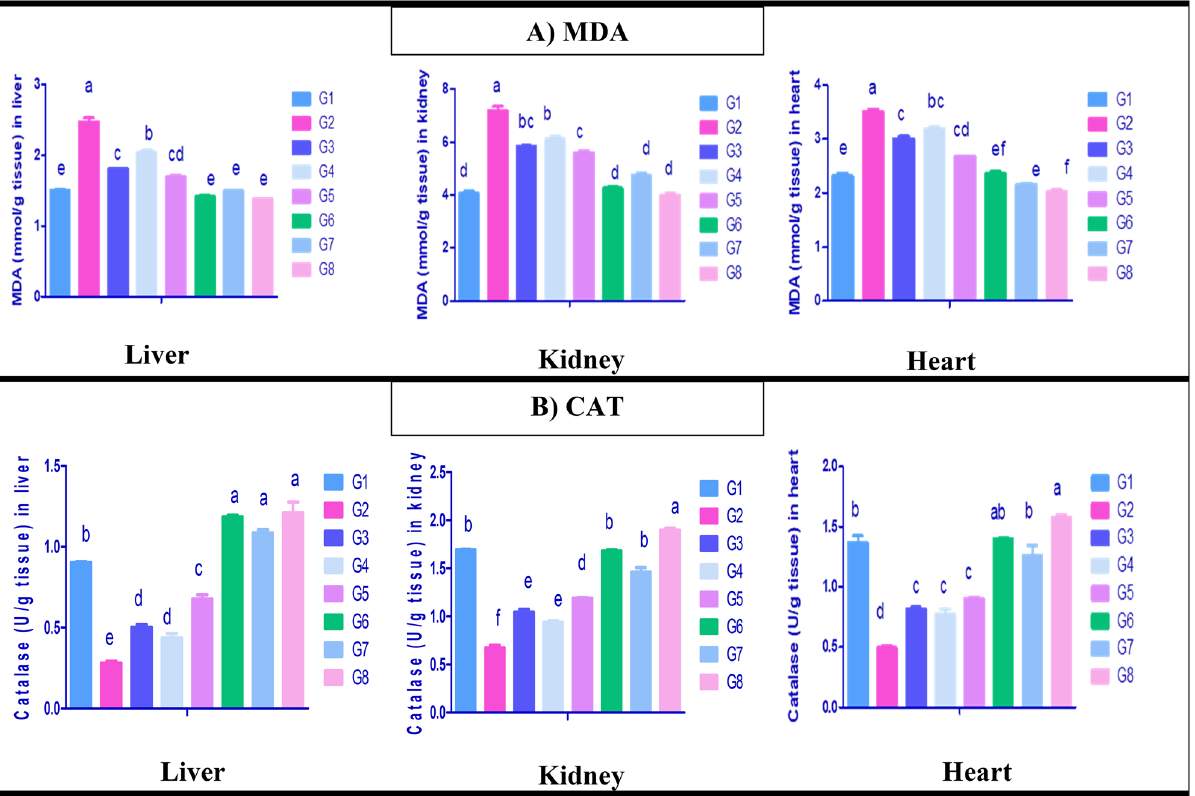
G1 = Control group, G2 = Paracetamol, G3 = Silymarin + Paracetamol, G4 = Chlorella vulgaris + Paracetamol, G5 = Chlorella vulgaris + Thiamine + Paracetamol, G6 = Silymarin, G7 = Chlorella vulgaris , G8 = Chlorella vulgaris + Thiamine. Data are presented as means ± SEM (n = 6). Different letter means significant difference effects in the same time